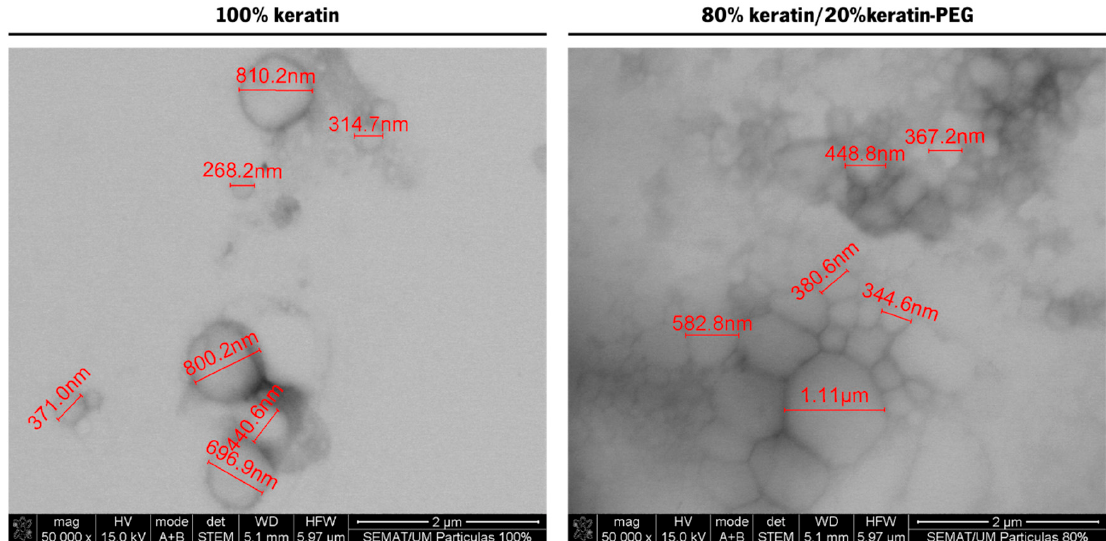
Figure 3. STEM micrographs (50,000×) of 100% keratin and 80% keratin/20% keratin-PEG particles. FTIR analysis was used to analyze the intermolecular interactions between keratin and PEGylated keratin during particle formation, as well as between the terbinafine and the keratin of the particles (Figure 4).